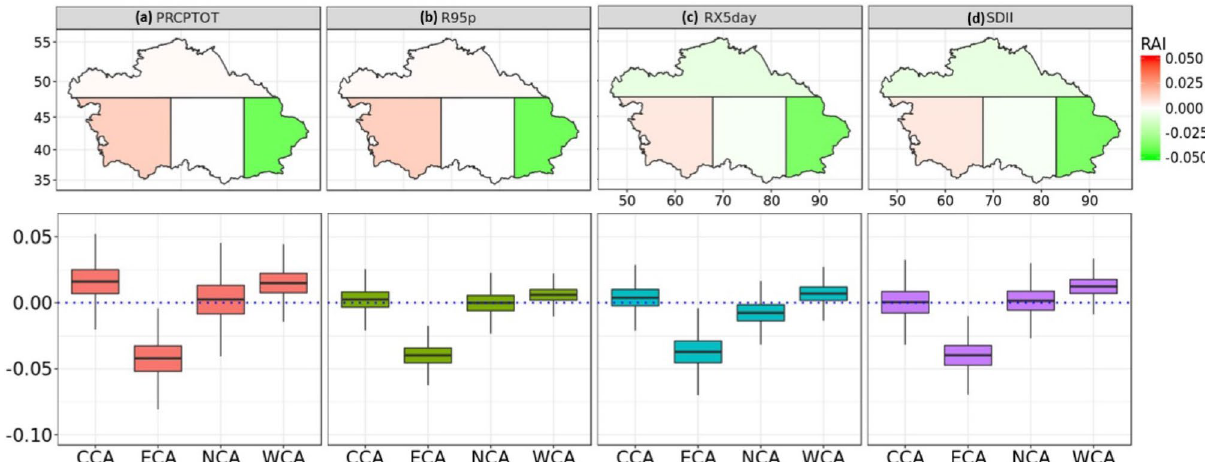
Figure 5. The figure on the upper panel shows the spatial distribution of the best temporal RAI estimates for the ( a ) PRCPTOT, ( b ) SDII, ( c ) R95p and ( d ) RX5day for 4 sub-regions in CA. The bottom panel indicates the corresponding uncertainty range (5th to 95th percentile) of the temporal RAI estimates for 4 sub-regions in CA. The horizontal lines in the box demonstrate the best estimate (i.e. median value). The subfigures were done in the software R 4.0.2 (https:// cran.r- proje ct. org/ bin/ windo ws/), and then the subfigures were merged by using the Microsoft PowerPoint 2013 software (https:// www. micro soft.